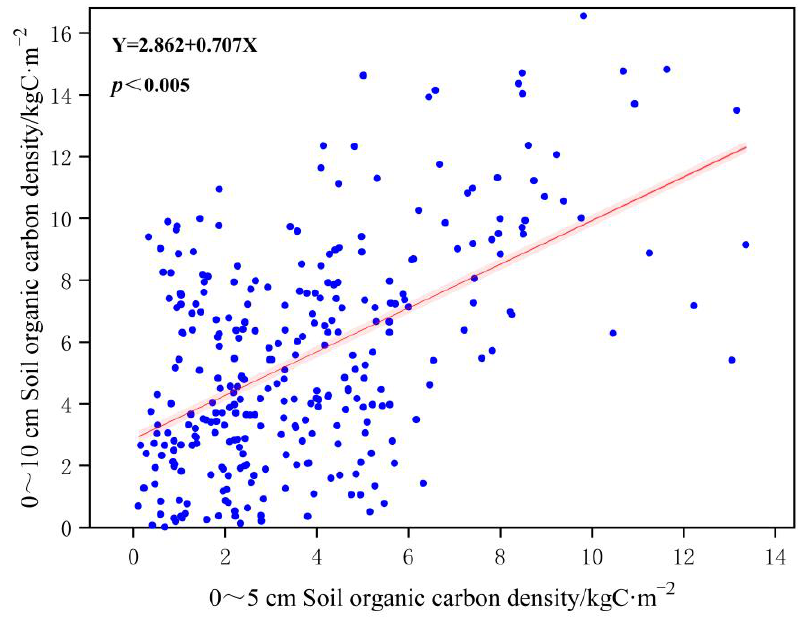
Figure 2. Carbon Density Verification.